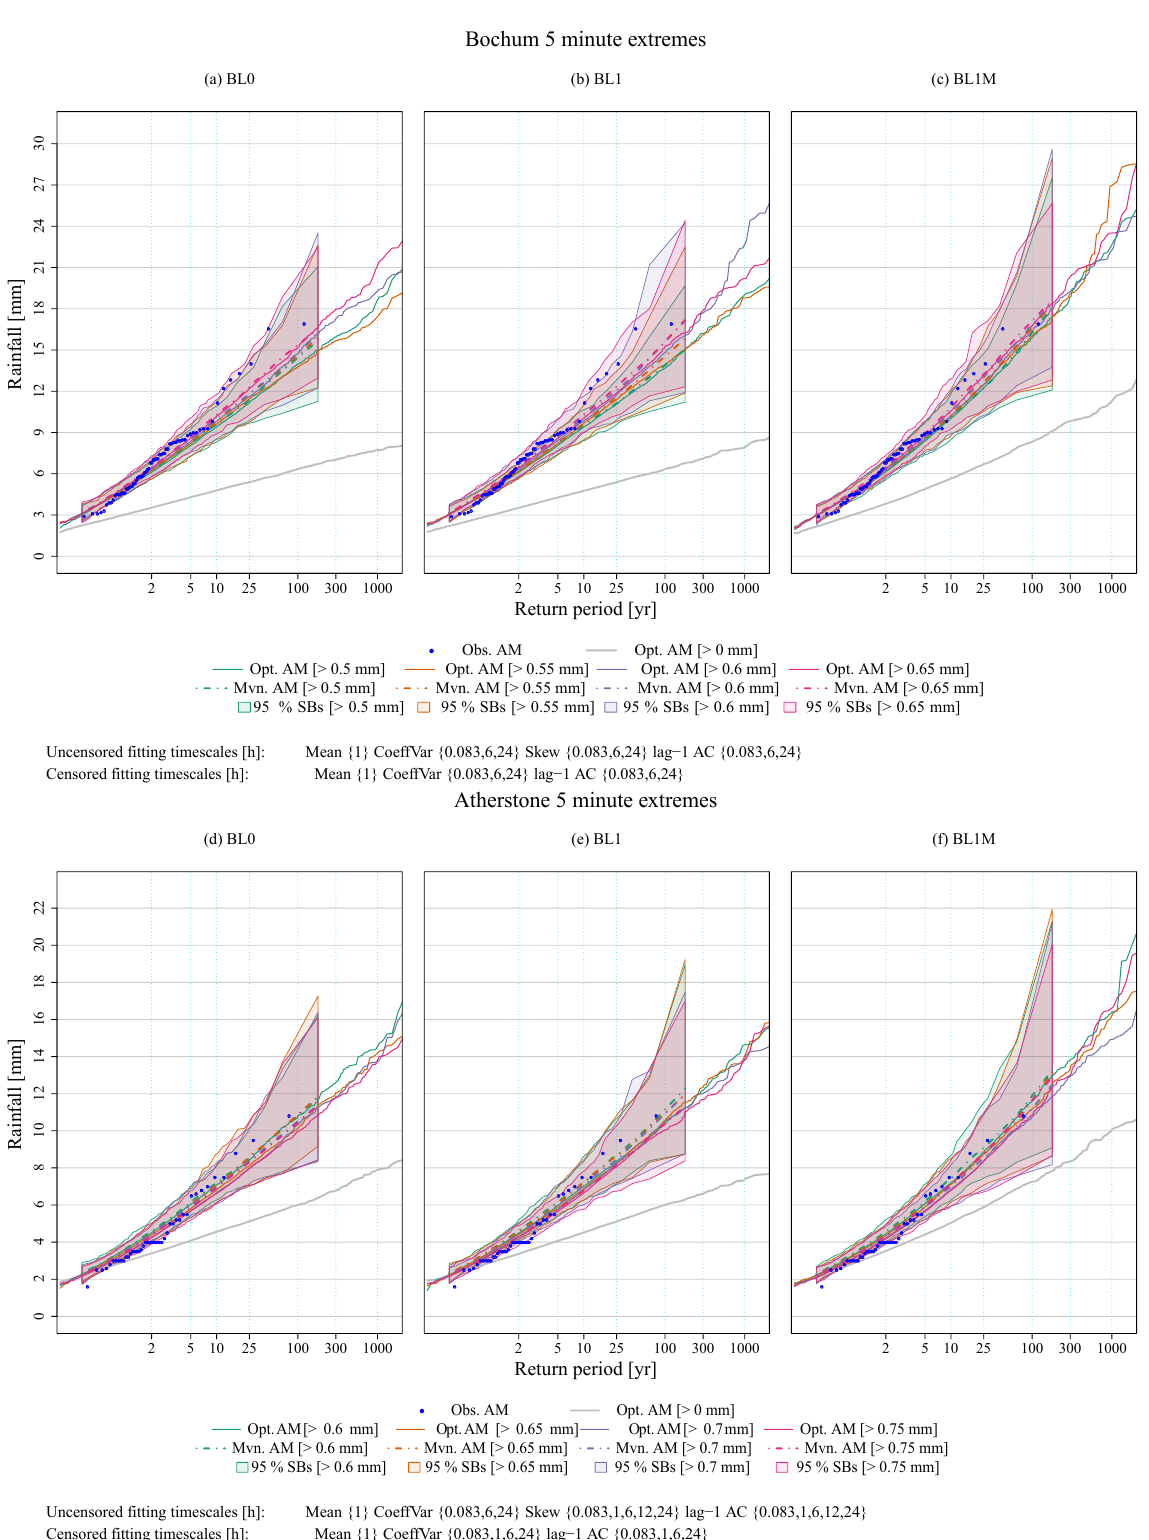
Figure 4. Extreme value estimation at 5min resolution. Optimal realizations (opt. AM) are shown with solid lines and the means of the MVN realization (mvn. AM) are shown with dashed lines. Simulation bands (SBs) are shown with filled